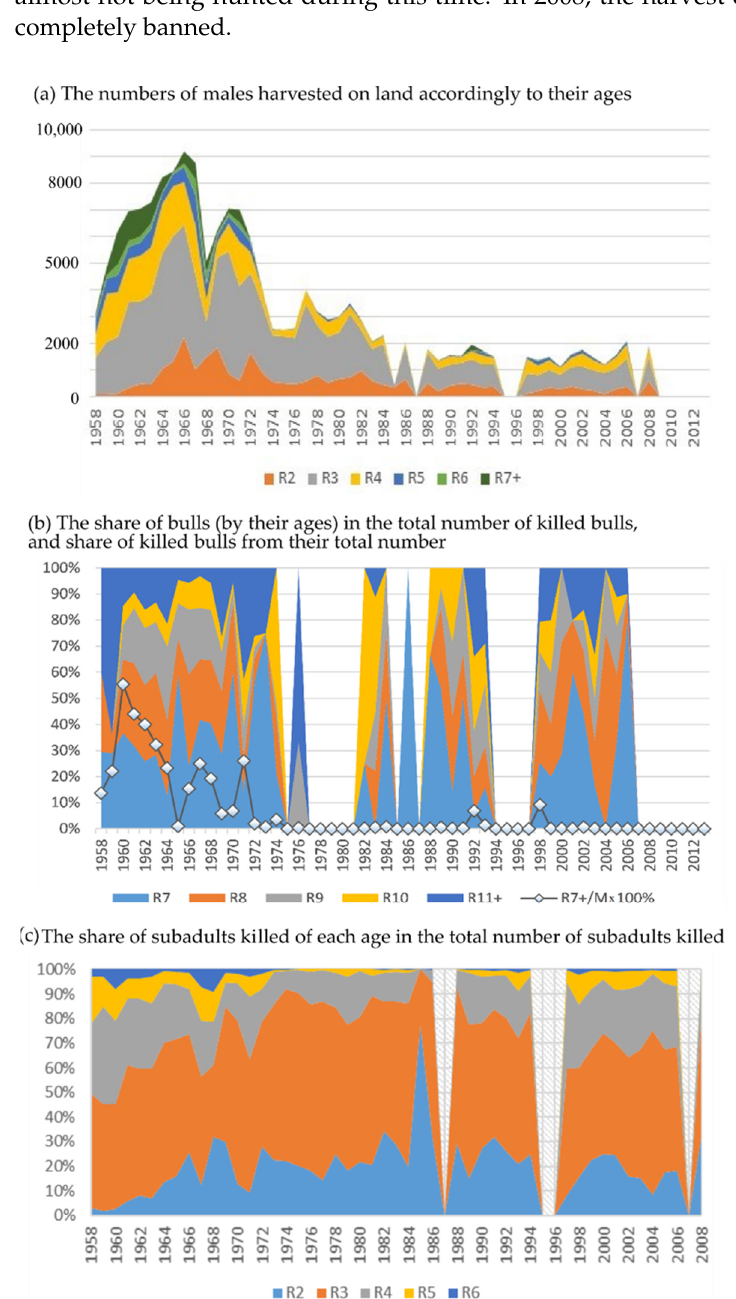
Figure 3. Structure of harvest. ( a ) The numbers of males harvested on land accordingly to their ages (R2–R6), bulls are included in the group of seven-year-olds and older (R7+). ( b ) The share of bulls (by their ages) in the total number of killed bulls, as well as that of killed bulls from their total number (the line with markers, R7 + ( n )/ M ( n )). ( c ) The share of subadults killed of each age in the total number of subadults killed.